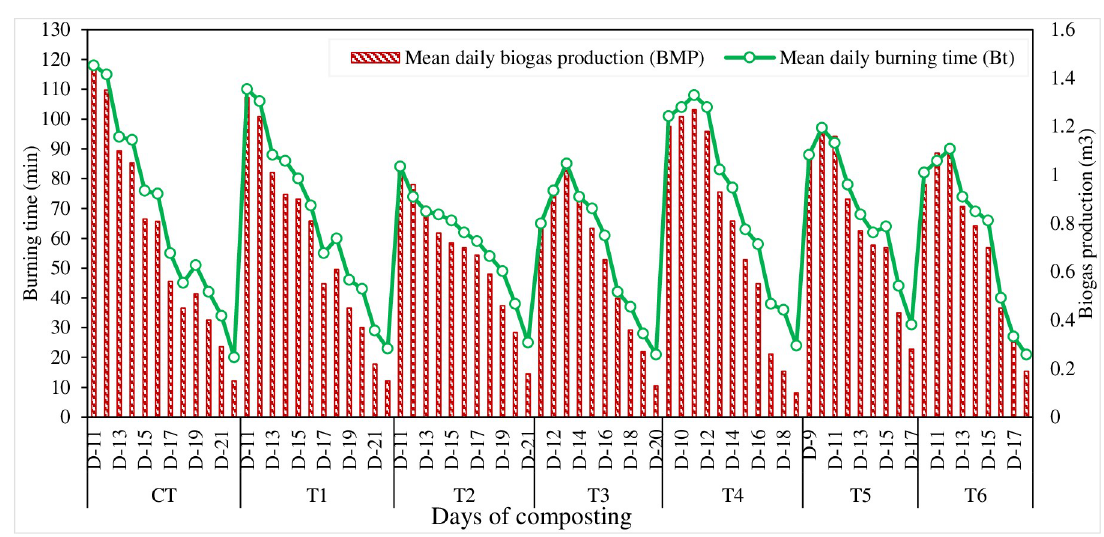
Fig 5. Mean daily methane production and their respective burning time of compost production under different treatments.